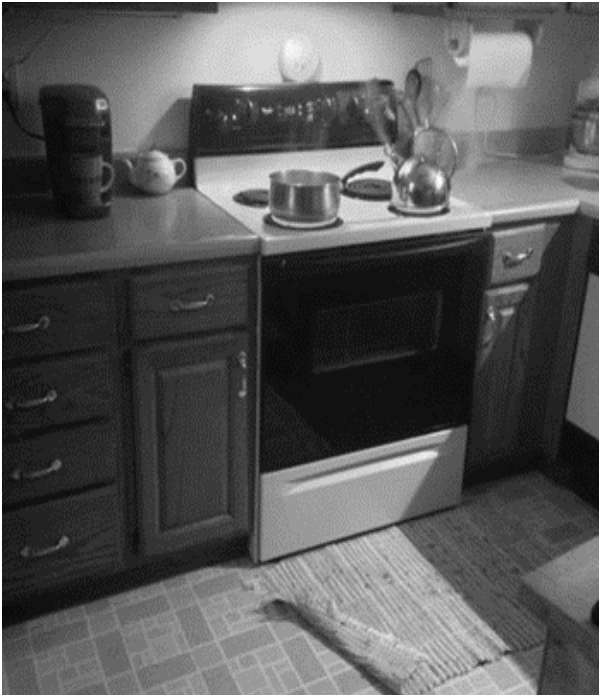
Figure 2. Participant 1 photo represented numerous times that she forgot items cooking. In the third telehealth